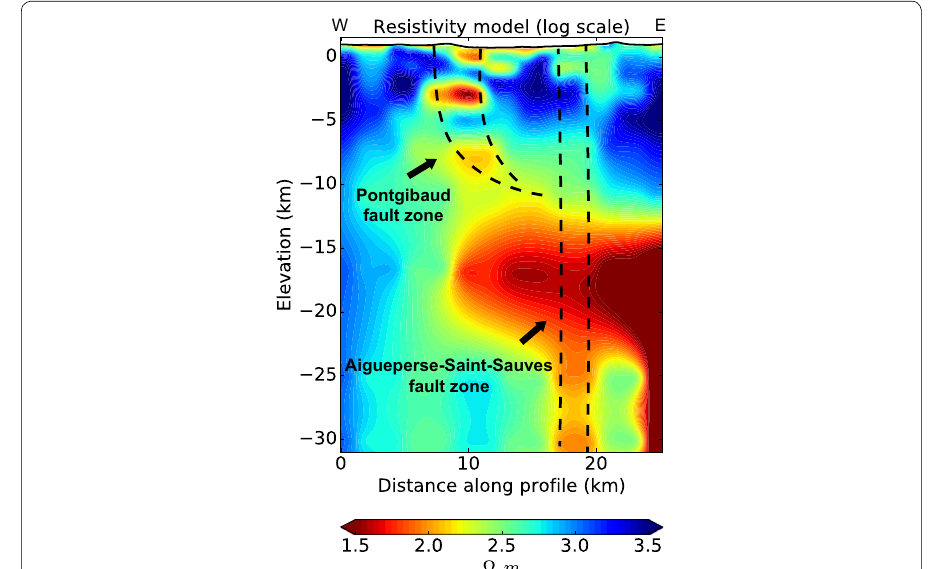
Fig. 3 2D resistivity profile. The dashed lines represent the hypothetical tracing of the deep structures, constrained by surface signatures (fault orientations and dips). (Ars et al.